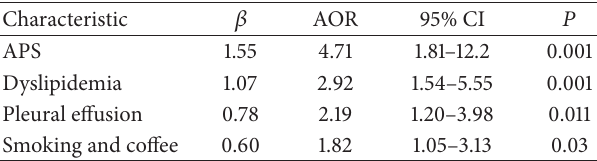
Table5:FactorsassociatedwithCVDinpatientswithSLEincluding interaction between smoking and coffee consumption ∗